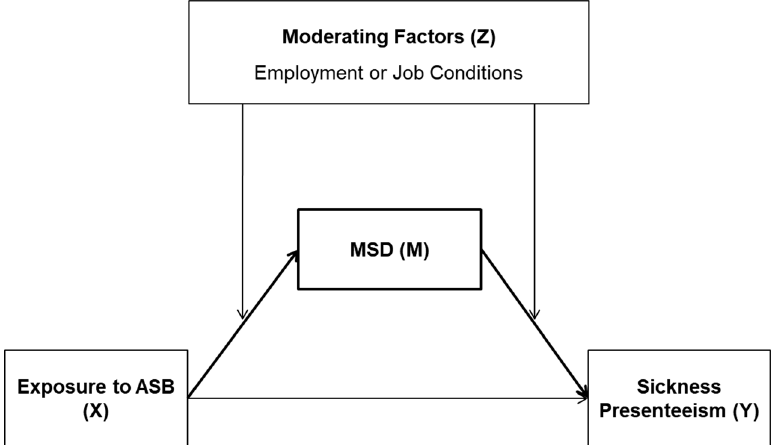
Figure 1. Hypothesized model for ASB, SP, MSDs, and Moderators.